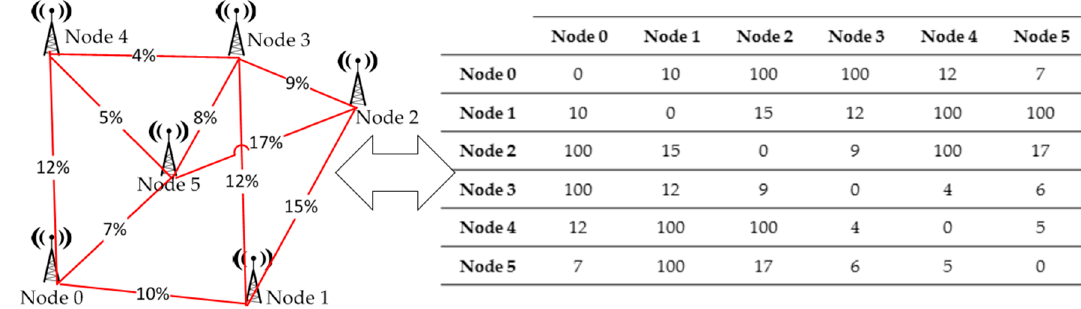
Figure 4. Wireless Network Model and packet-loss probability matrix.